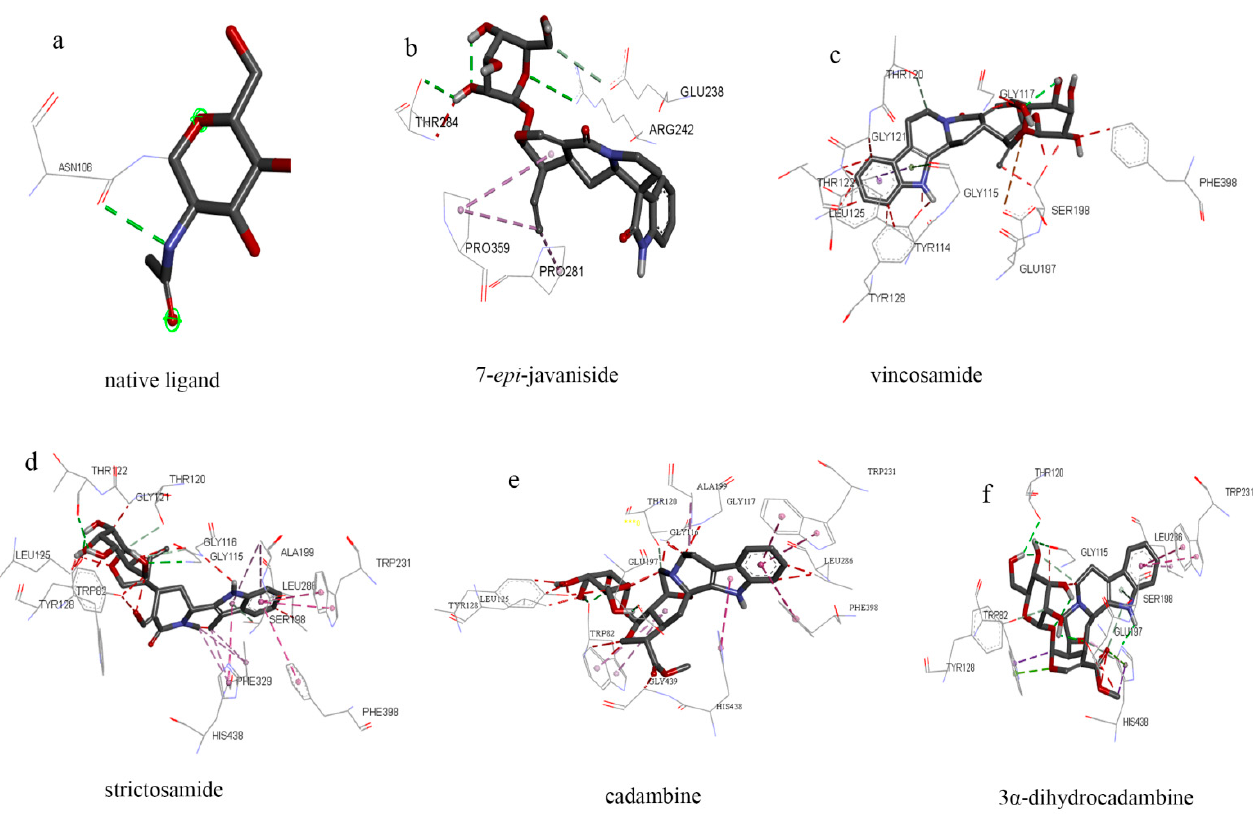
Figure 7. Three-dimensional (3D) figures of molecular docking between compounds 1 – 5 and BuchE (( a ), native ligand; ( b – f ), compound 1 – 5 ). (( a ), native ligand; ( b – f ), compounds 1 – 5